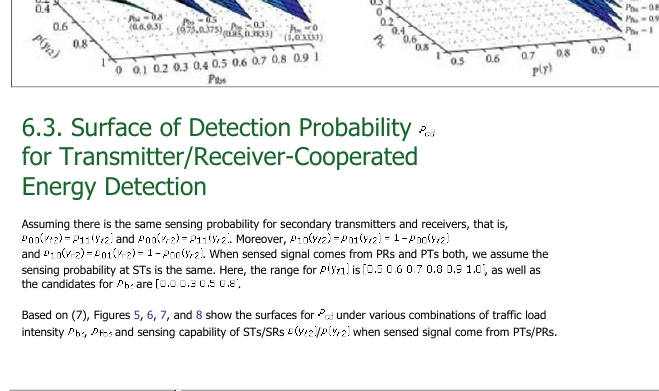
Figure 5In Generic Scenario, Detection Probability of for Transmitter/Receiver- Cooperated Energy Detection for (a) , (b) and